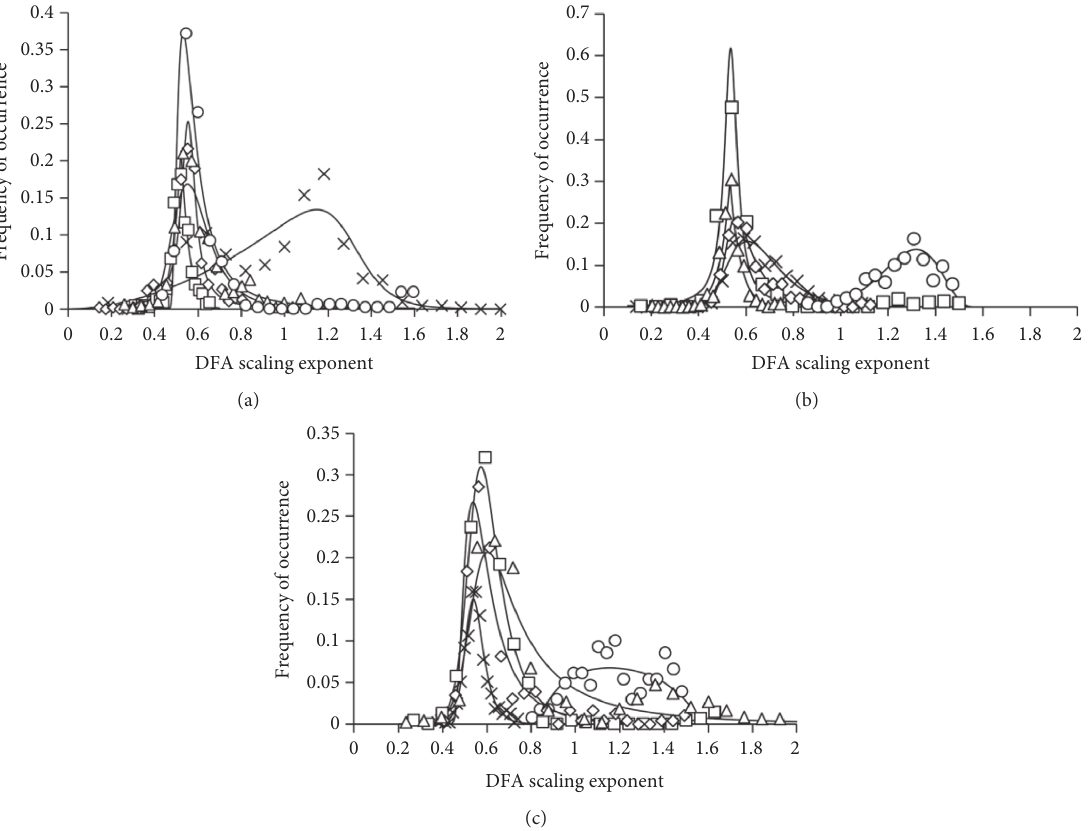
Figure 4: Frequency of occurrence of DFA scaling exponents of RTT time series calculated for first (a), second (b), and third (c) nights, night-time measurements. Scaling exponents have been calculated for consecutive 1000 data windows shifted by 100 data steps. Crosses: GTU, squares: Harvard, diamonds: UCLA, triangles: USC, and circles: